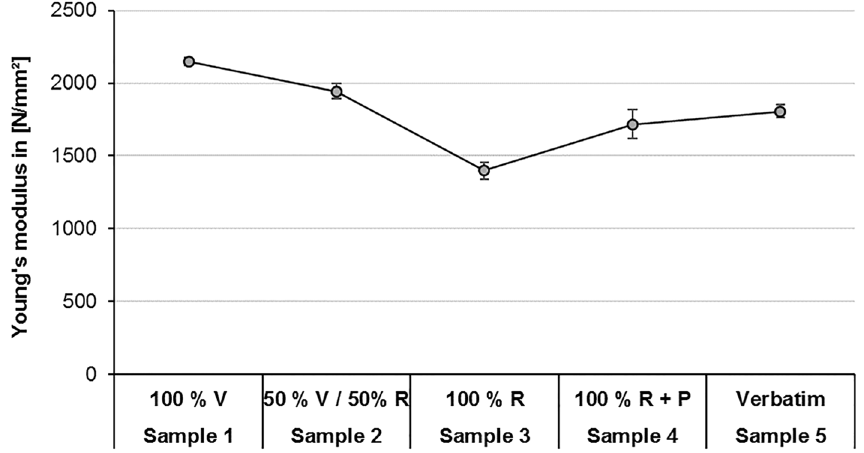
Fig. 11 Overview of the Young’s modulus for the differ- ent filament